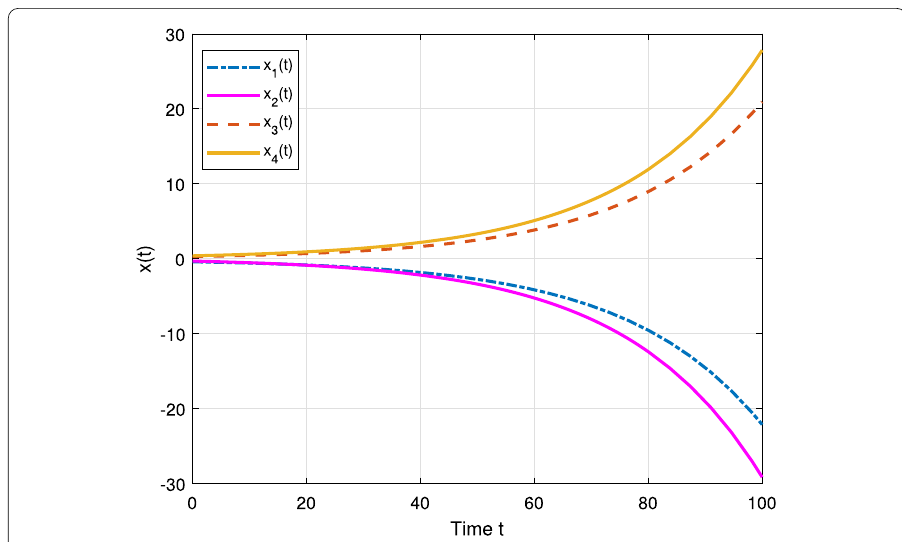
Figure 7 State responses of x ( t ) against u ( t ) = 0 of the GNNs (47) in Example 4.4